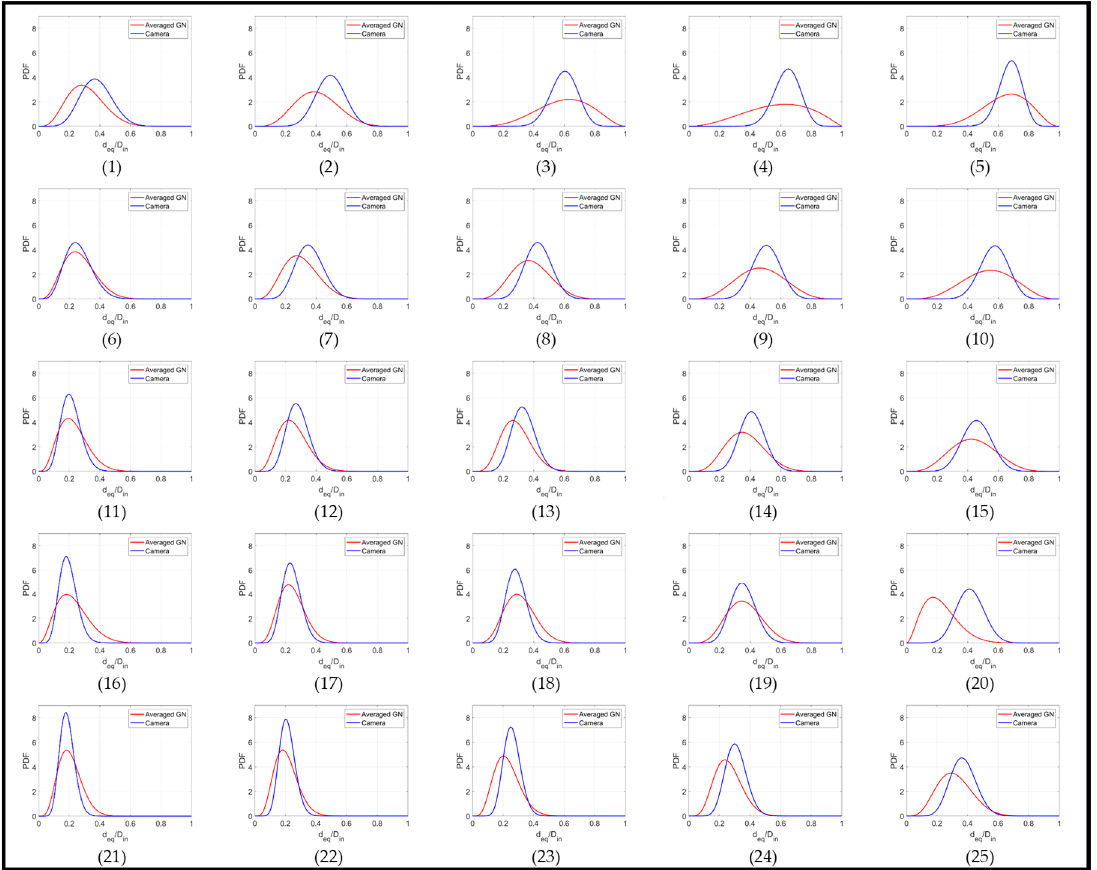
Figure 19. Probability Density Functions for the equivalent core diameter of each experimental point studied. Camera Beta distributions are plotted in blue, while the corrected ERT distributions are plotted in red.